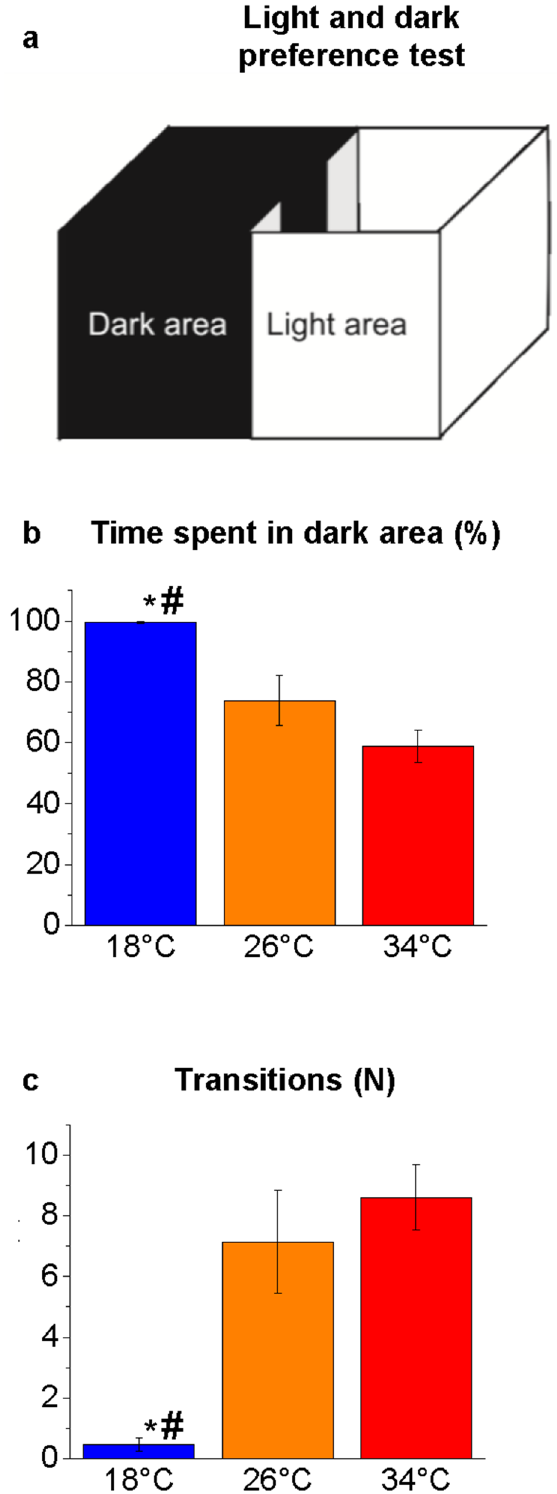
Figure 2. Scototaxis behaviour in the LDT. Schematic representation of the apparatus ( a ). Time spent in the dark area ( b ) and number of passages between the bright and dark areas ( c ). The data are expressed as mean ± S.E.M. and analysed by one-way ANOVA with Bonferroni post hoc correction. P ≤ 0.05, * 18 °C versus 26 °C; # 18 °C versus 34 °C and $ 34 °C versus 26 °C. P values are reported in Table S3. N =